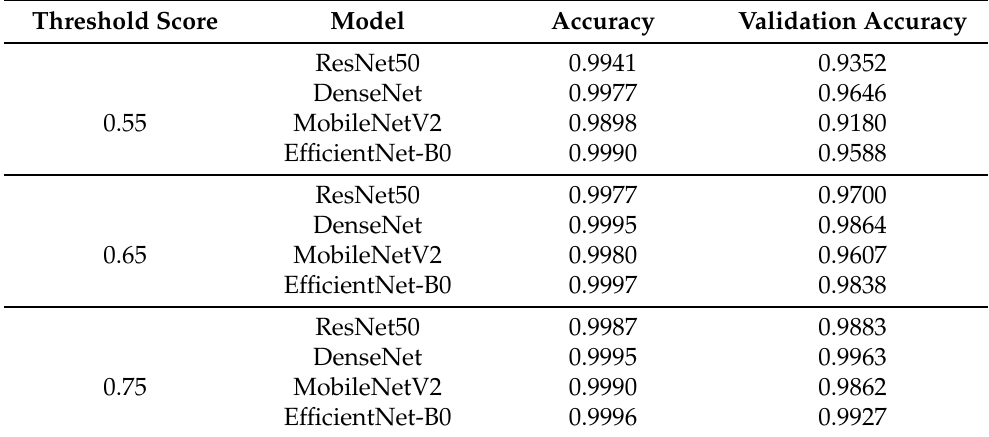
Table 4. The accuracy of all comparison methods is presented with threshold scores of 0.55, 0.65, and 0.75.